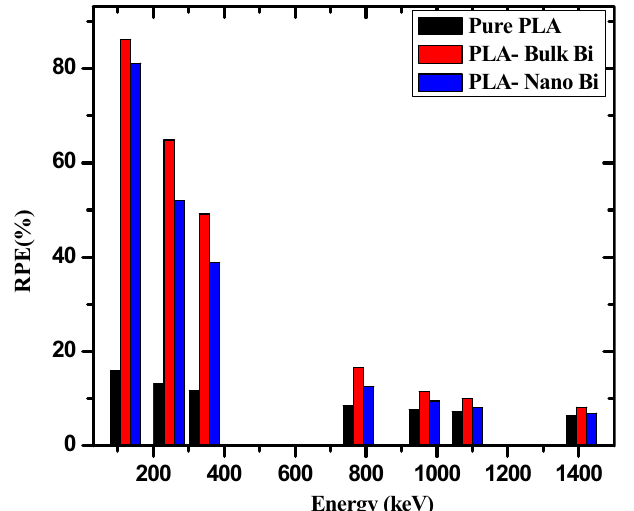
Figure 8. The RPE for the pure PLA, PLA with bulk Bi, and PLA with nano Bi at different energies.